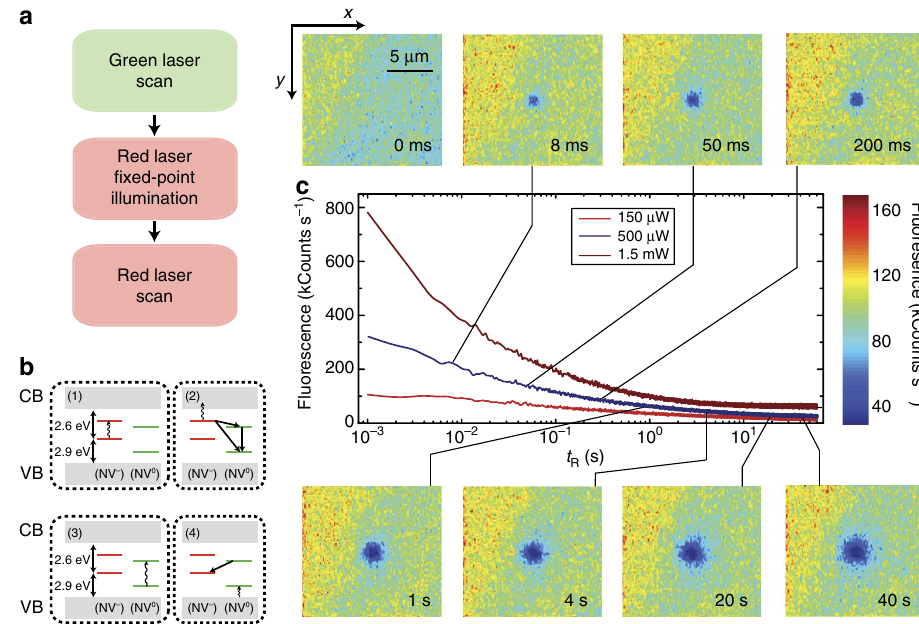
Figure 1 | Red-light-induced bleaching of the NV (cid:2) fluorescence. ( a ) Experimental protocol. On a green laser sample scanning, we station the red beam at a fixed spot for a predefined, variable time, to finally image the area via a red beam scan. During the fixed-point illumination and scanning times the green beam is off. ( b ) NV ionization takes place via a two-step process in which the excess electron is ejected into the conduction band (CB) by the consecutive absorption of two photons of wavelength l r 632nm (steps 1 and 2). NV 0 recharging takes place on absorption of an electron from the valence band (VB) following excitation with l r 575nm (steps 3 and 4). ( c ) The central figure displays the sample fluorescence as a function of the red illumination time t R for three different excitation powers before the readout scan. The top/down inserts correspond to fluorescence images obtained on scanning the red beam over an area xy on the focal plane around the fixed point. The time lapse t R before sample scanning is indicated in the lower right corner of each image. In all images, the green laser power is 750 m W; note that the red laser power is 500 m W during t R and 100 m W during the readout scanning, thus leading to different fluorescence intensities. Each image has 100 (cid:5) 100 pixels and the integration time per point is 1ms both throughout the scanned images and the fluorescence time traces in the central